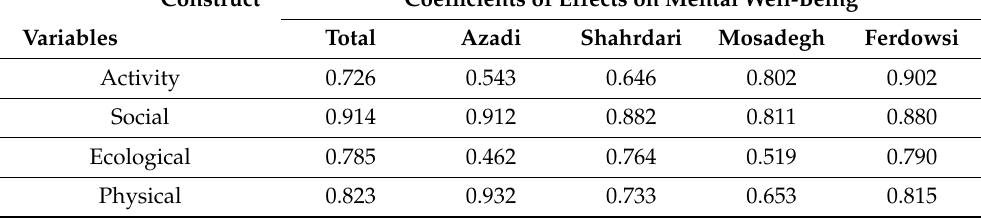
Table 8. The effects of environmental quality dimensions for each public open space on mental well-being.